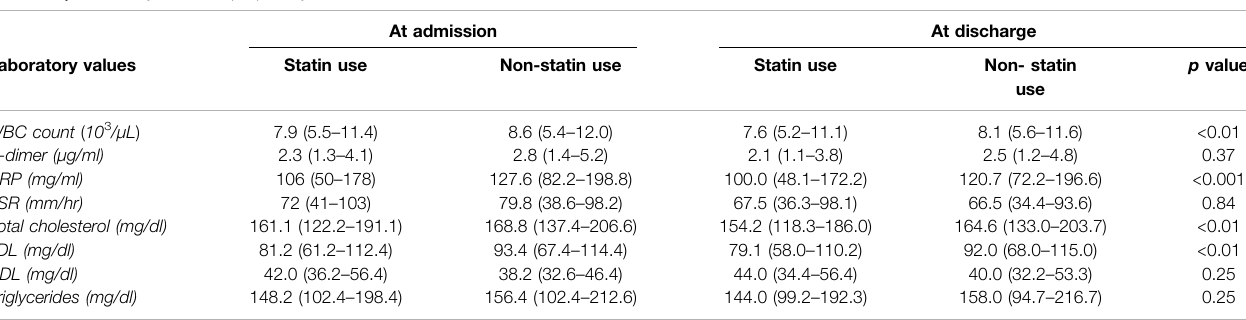
TABLE 3 | Laboratory values in propensity-matched